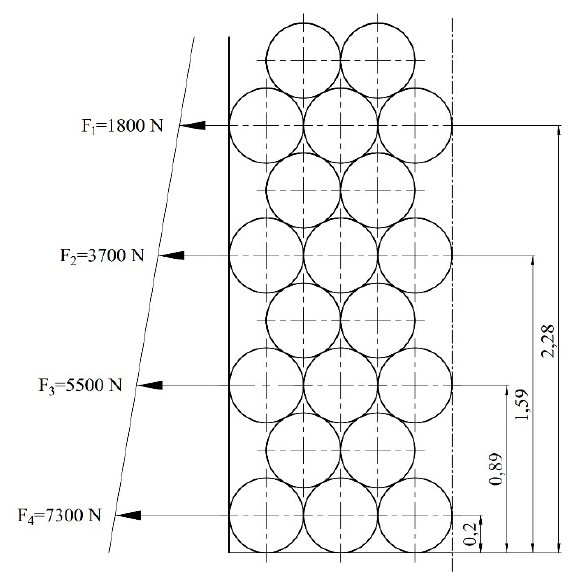
Figure 4. Log arrangement and static load distribution on the stanchion (dimensions in meters).